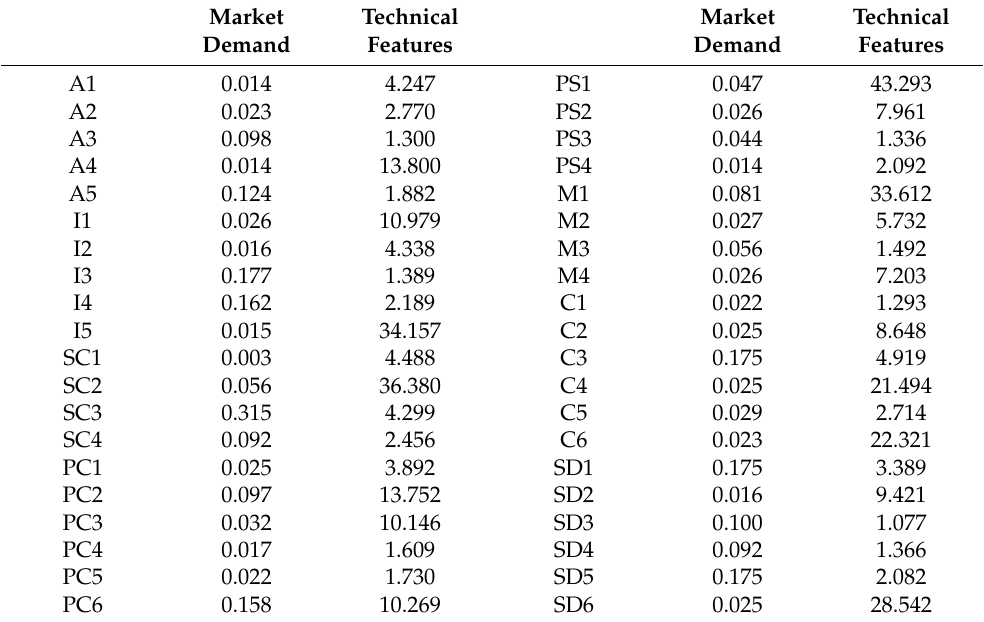
Table 9. Technical features and market demand of technology